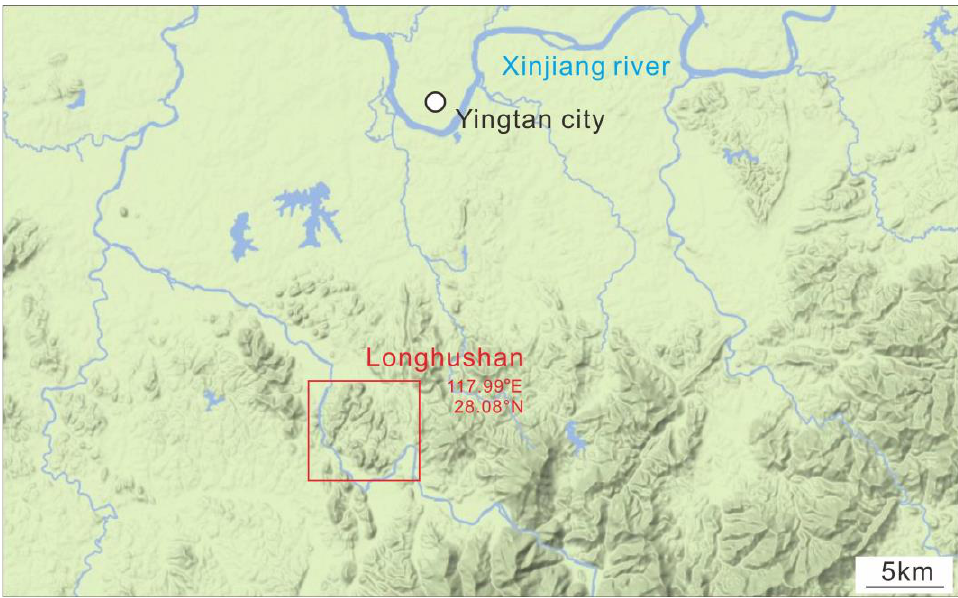
Figure 1. The geographic map shows the location of the Longhushan area.